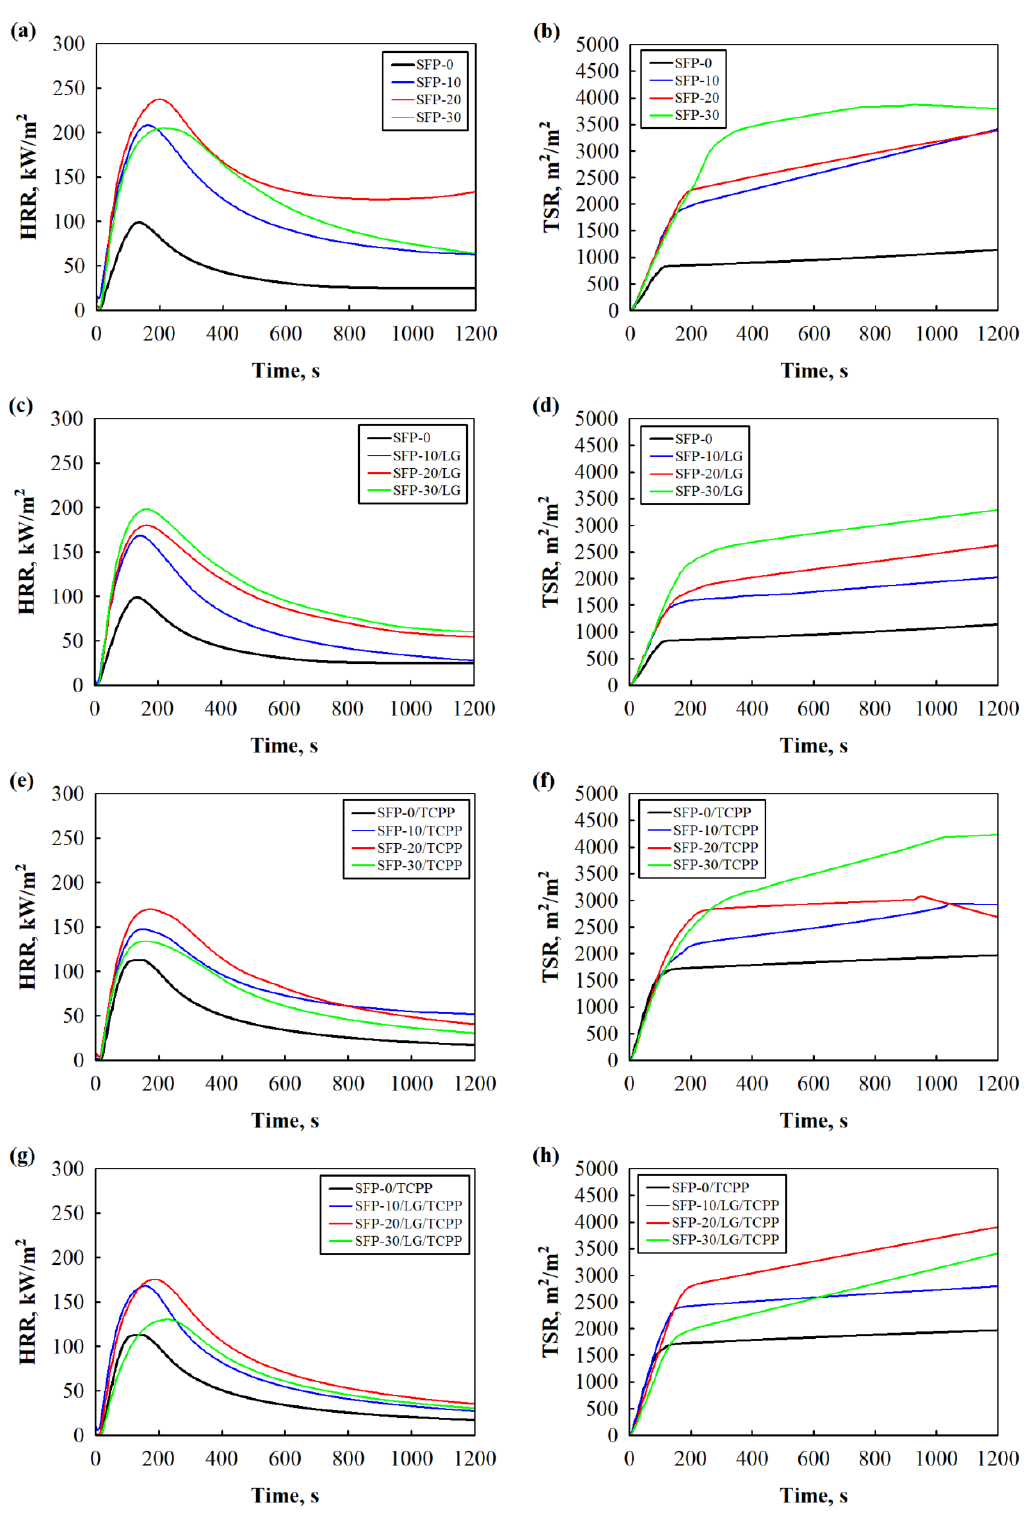
Figure 5. HRR and TSR of: ( a , b ) PUR foams with SFP filler; ( c , d ) PUR foams with LG-modified SFP filler; ( e , f ) flame retardant PUR foams with SFP filler; and ( g , h ) flame retardant PUR foams with LG-modified SFP filler.